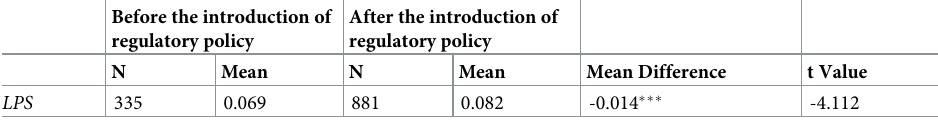
Table 1. Group differences in the shareholding of large private shareholders. Before the introduction of regulatory